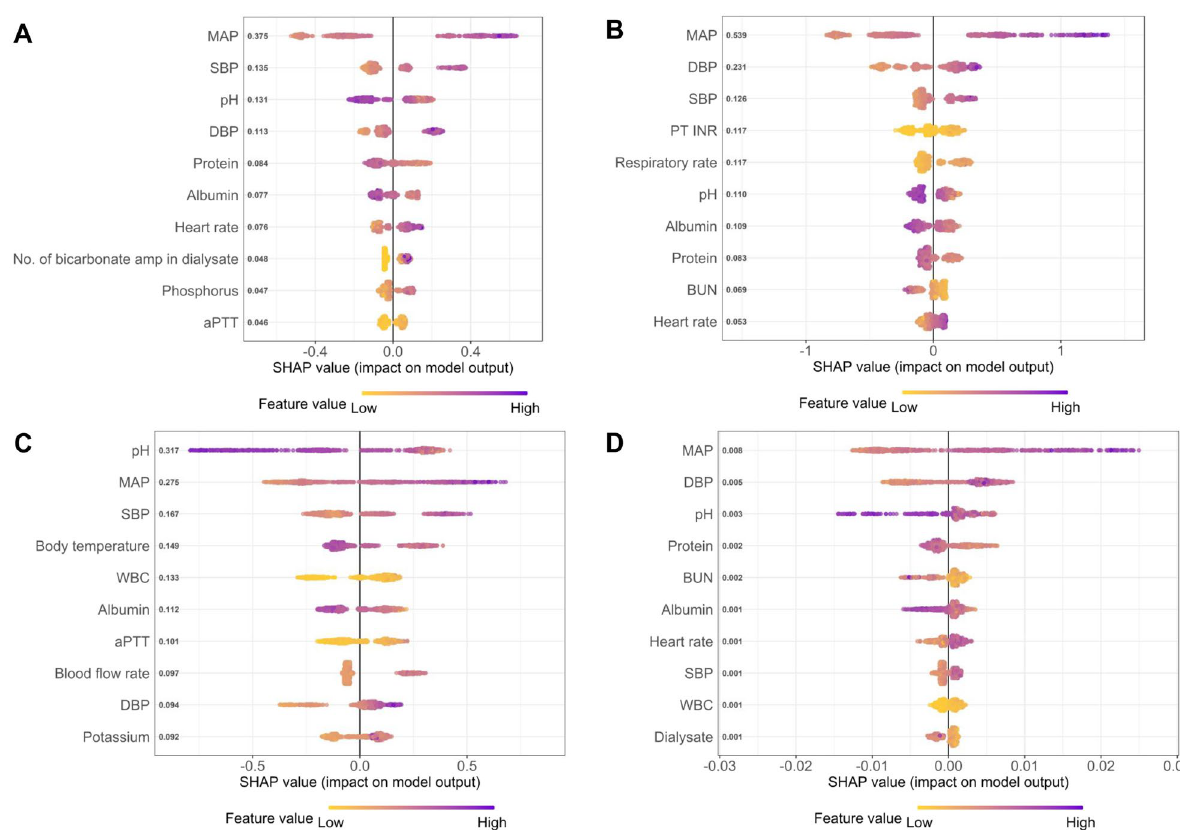
Figure 2. Feature ranking analysis of the light gradient boosting machine model in predicting a reduction in mean arterial pressure (MAP) ≥ 20 mmHg ( A , C ) and ≥ 30 mmHg ( B , D ) within 6 h ( A , B ) and 1 h ( C , D ). MAP mean arterial pressure, SBP systolic blood pressure, DBP diastolic blood pressure, aPTT activated partial thromboplastin time, PT-INR prothrombin time-international normalized ratio, BUN blood urea nitrogen, WBC white blood